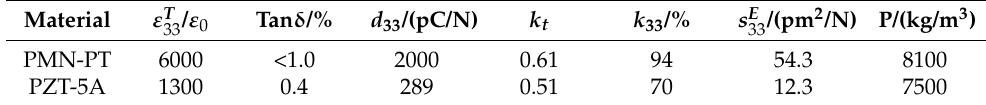
Table 1. Comparison of some element parameters between PMN-PT and